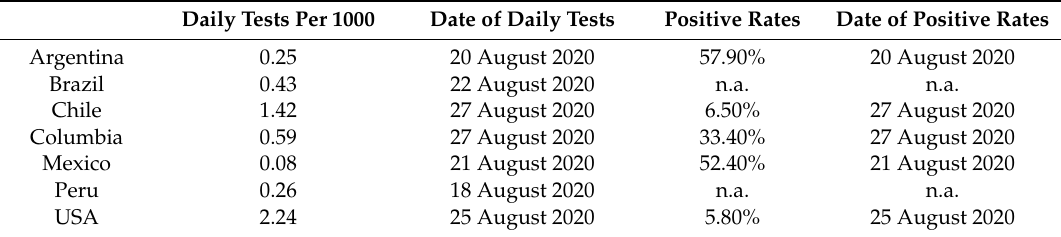
Table 2. The daily viral tests and positive rates for countries